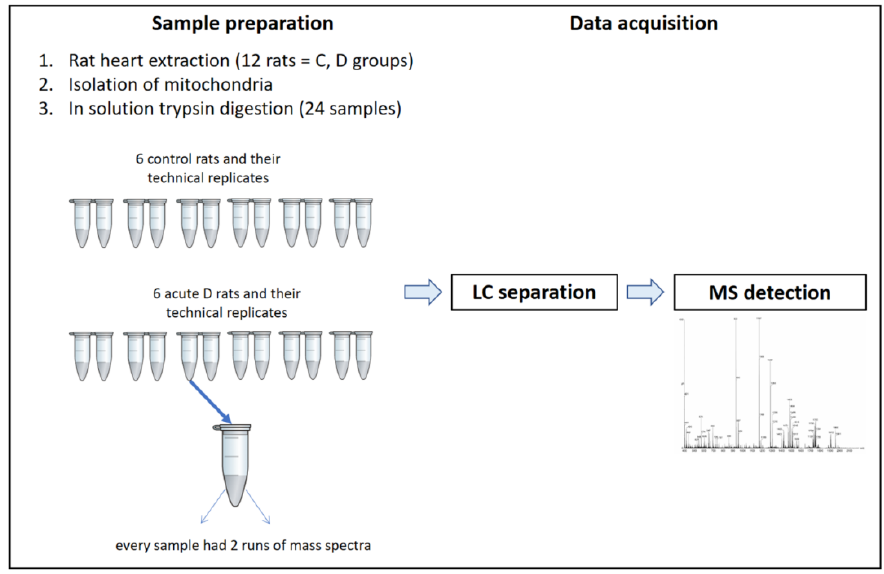
Figure 6. LC-MS Figure 6. LC-MS workflow.